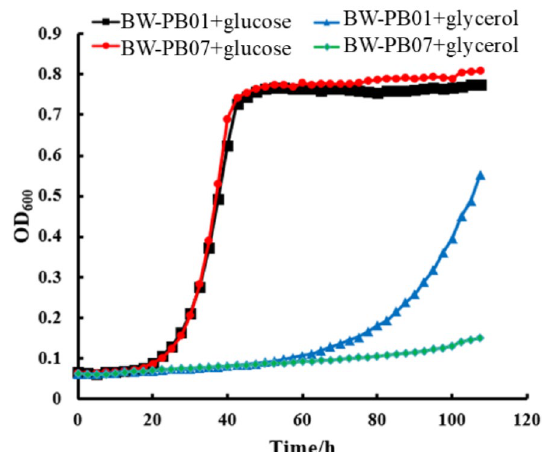
Figure 5. In vivo NCD cycling supports E. coli growth. Engineered strains assembled with different NCDH- consuming reactions were cultured in liquid minimal media with glucose or glycerol as carbon source and 5 mM phosphite as the sole phosphorous source. Data are the average of biological triplicates with standard